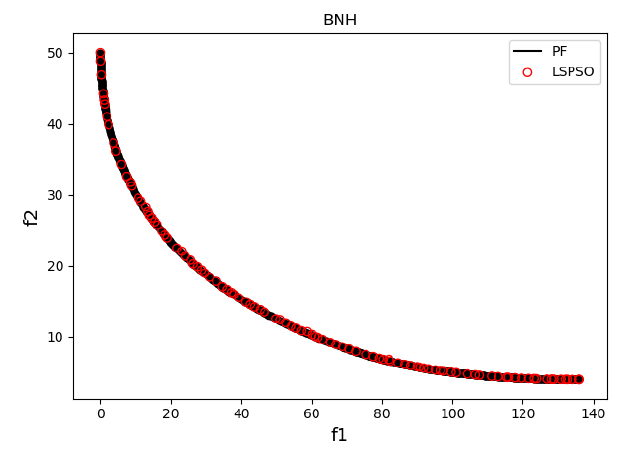
Figure 3. Pareto optimal solutions obtained by LSPSO for BNH.